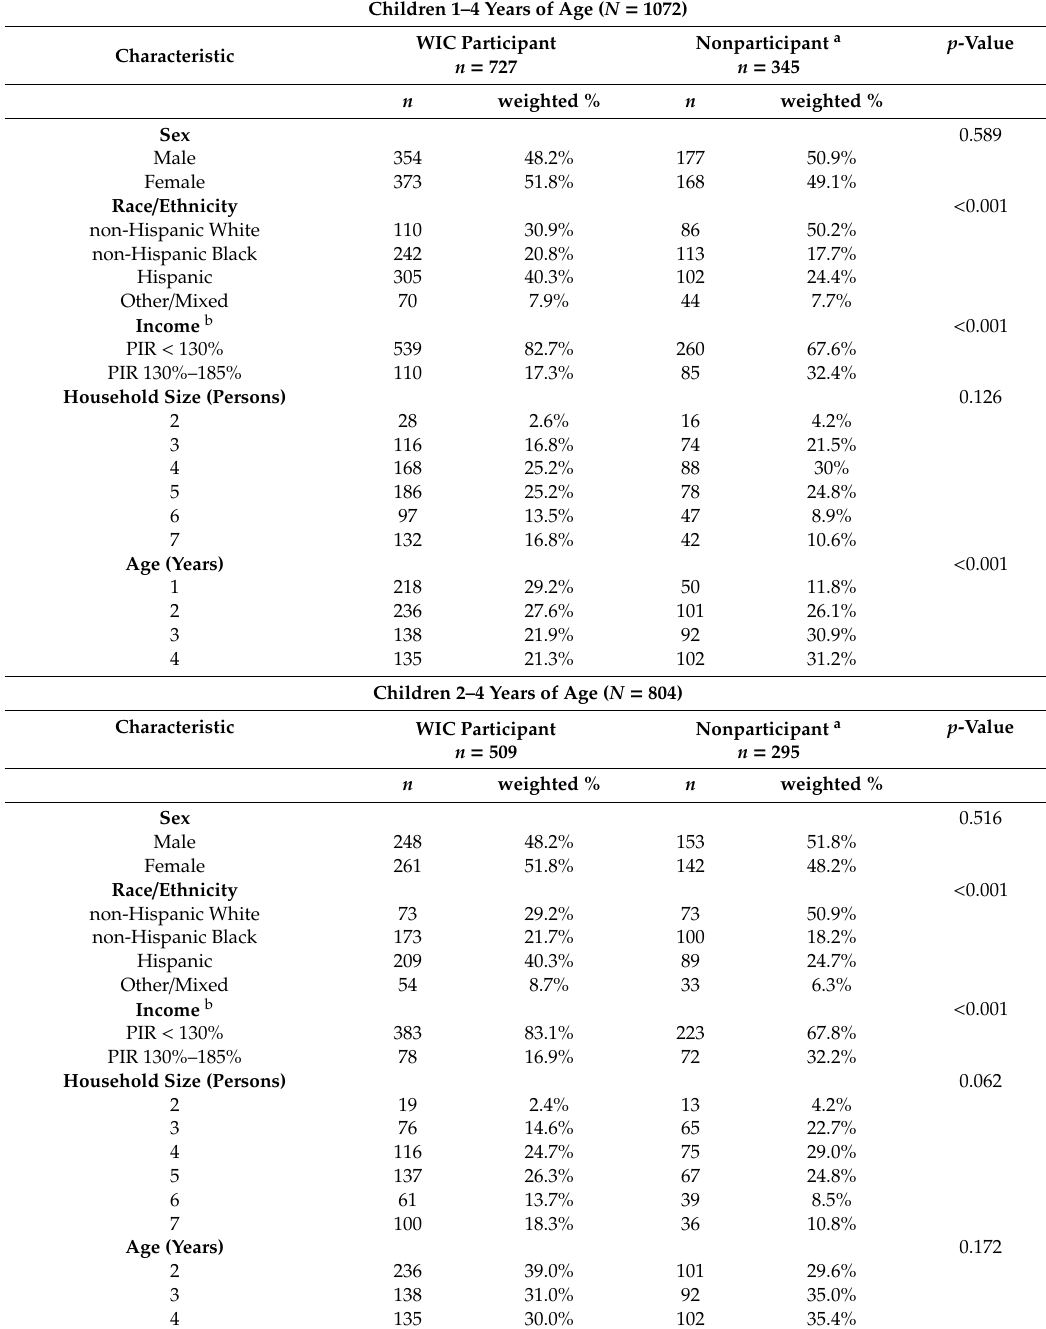
Table 1. Sociodemographic characteristics by Special Supplemental Nutrition Program for Women, Infants, and Children (WIC) participation status for U.S. children in the NHANES